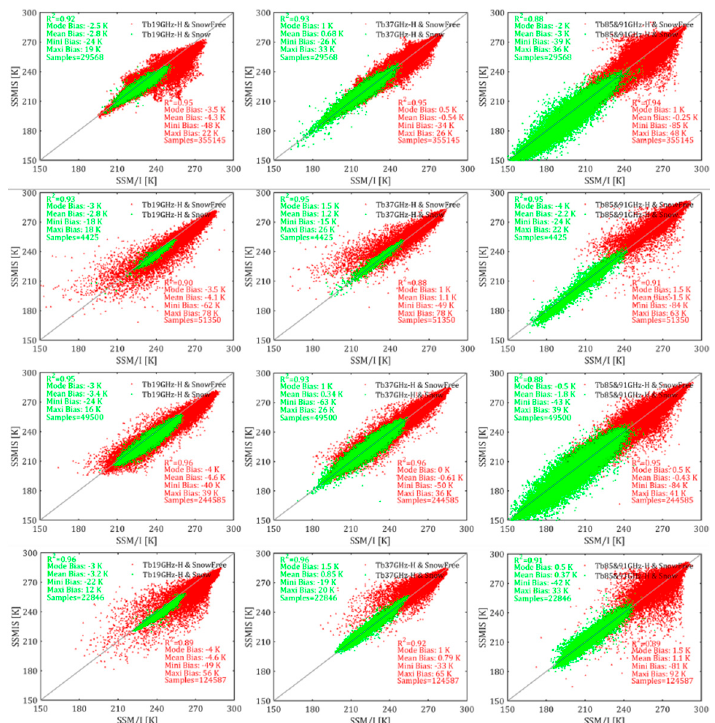
Figure 3. Scatter plots of brightness temperature between SSM / I and SSMIS, including 19.35 GHz ( left ), 37 GHz ( middle ), and 85.5 (91.655) GHz ( right ) in four main land cover types. Top: barren land; second: farmland; third: grassland; bottom: forest. The red triangle and green triangle denote brightness temperature in a snow-free pixel and snow-covered pixel, respectively. The gray solid line represents the 1:1 line.